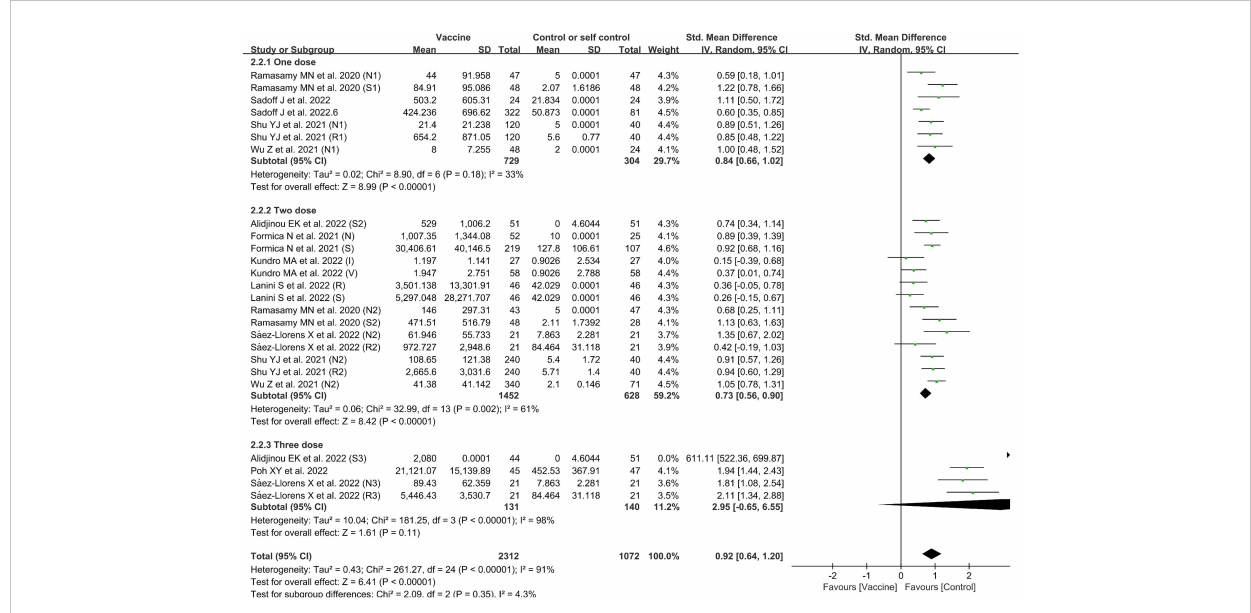
FIGURE 6 Forest plots of geometric mean titers (GMT) by number of doses for the coronavirus disease 2019 (COVID-19) vaccine group compared with the control group. N , neutralizing antibody; S , anti-S antibody; R , anti-RBD antibody; 1 , one dose; 2 , two doses; 3 , three doses; I , inactivated vaccine; V , viral vector vaccine.